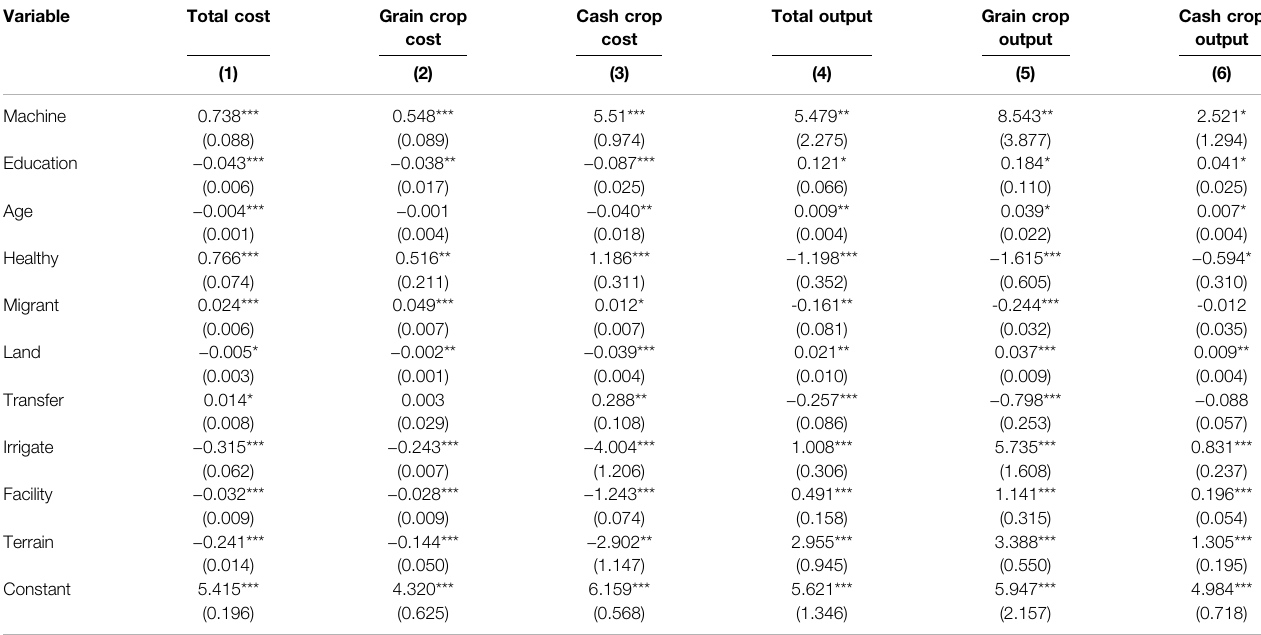
TABLE 4 | IVTobit estimation of the impact of agricultural mechanization level on cost and output. Variable